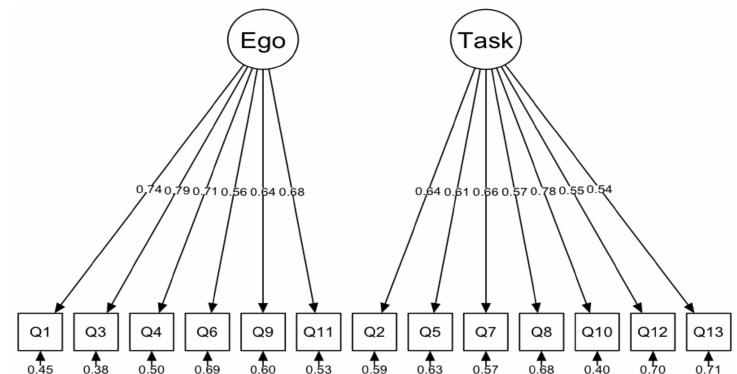
Figure 4. Factor model of TEOSQ questionnaire (Chi-sq = 539.67, df = 65, p < 0.001, CFI = 0.840, TLI = 0.808, SRMR = 0.068, RMSEA = 0.106, CI.90